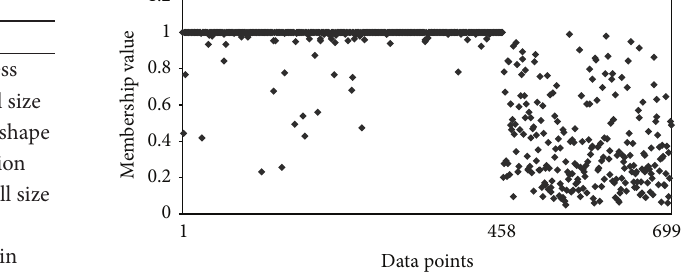
Table 1: Information about features.